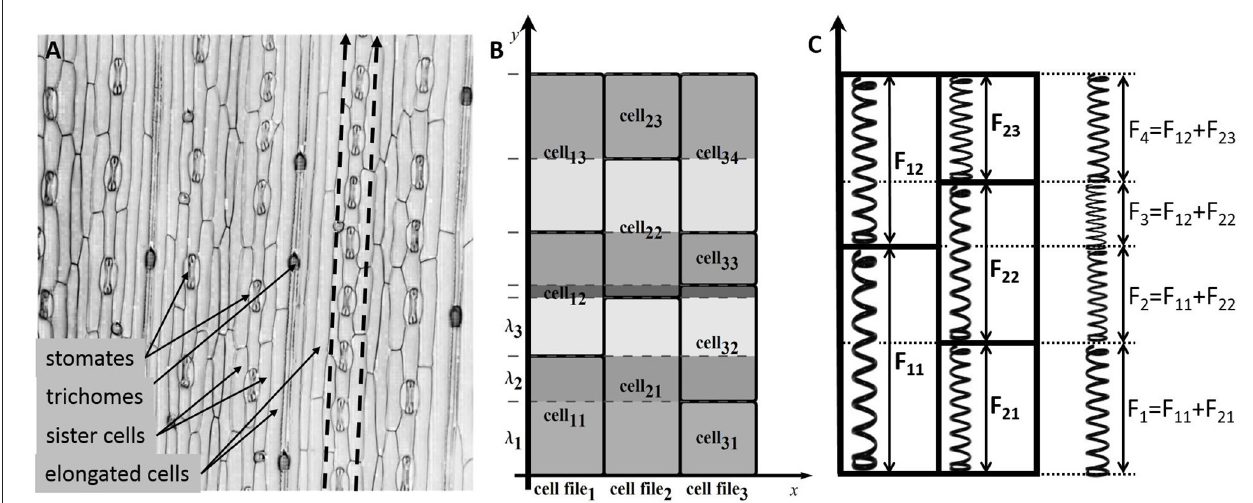
FIGURE 1 | The cell structure of the wheat leaf epidermis. (A) Micro-photograph of the wheat leaf epidermis (constructed from a 3D confocal image of the wheat leaf epidermis, supplied courtesy of A. Doroshkov), where dashed arrows mark cell files. (B) The scheme of partitioning of cells of the “model leaf” into λ 1 , λ 2 , λ 3 ,... fragments . With this partition, e.g., the fragment λ 2 belongs to the cells cell 11 , cell 21 , and cell 32 . (C) The force stretching a fragment is the sum of (cid:8) (cid:9) forces stretching the cells that include the fragment.